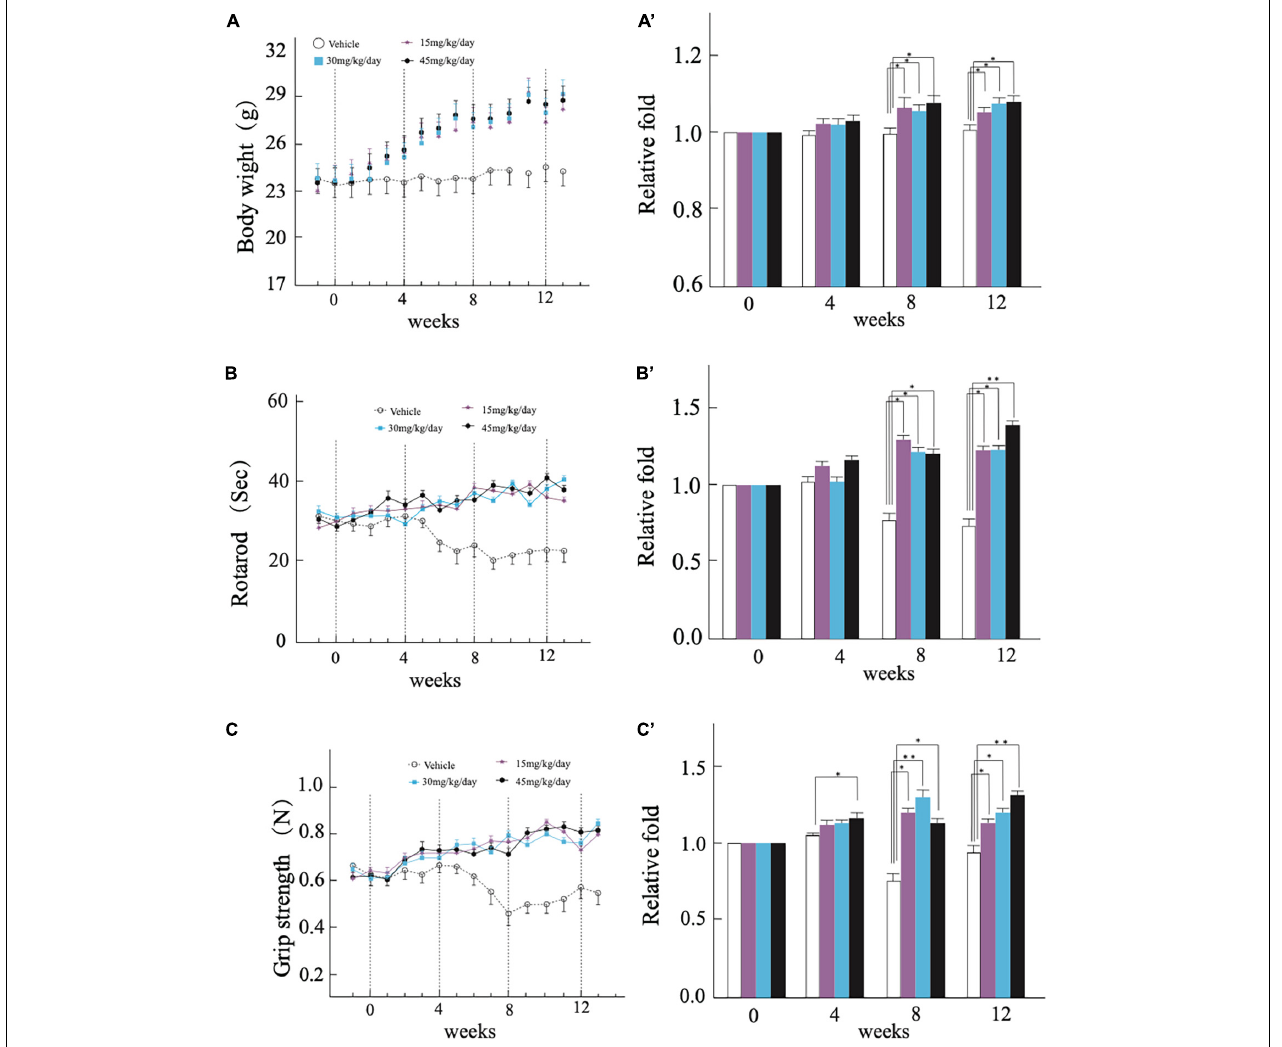
FIGURE 1 | Continuous treatment with Wen-Shen-Jian-Pi (WSJP) prescription for 12 weeks to rescue motor dysfunction in AR2 mice. Changes in (A) mouse body weight, (B) latency of the mouse to fall on the rotarod task, (C) mouse grip strength each week during the experiment for the WSJP-treated AR2 mice ( n = 18; n = 5 male, n = 13 female) and vehicle-treated AR2 mice ( n = 6; n = 2 male, n = 4 female). Panels (A (cid:48) –C (cid:48) ) indicate the relative fold change for each group. Data are shown as the mean ± the standard error of the mean (SEM). * p < 0.05, ** p < 0.001 compared with time zero at each subsequent time